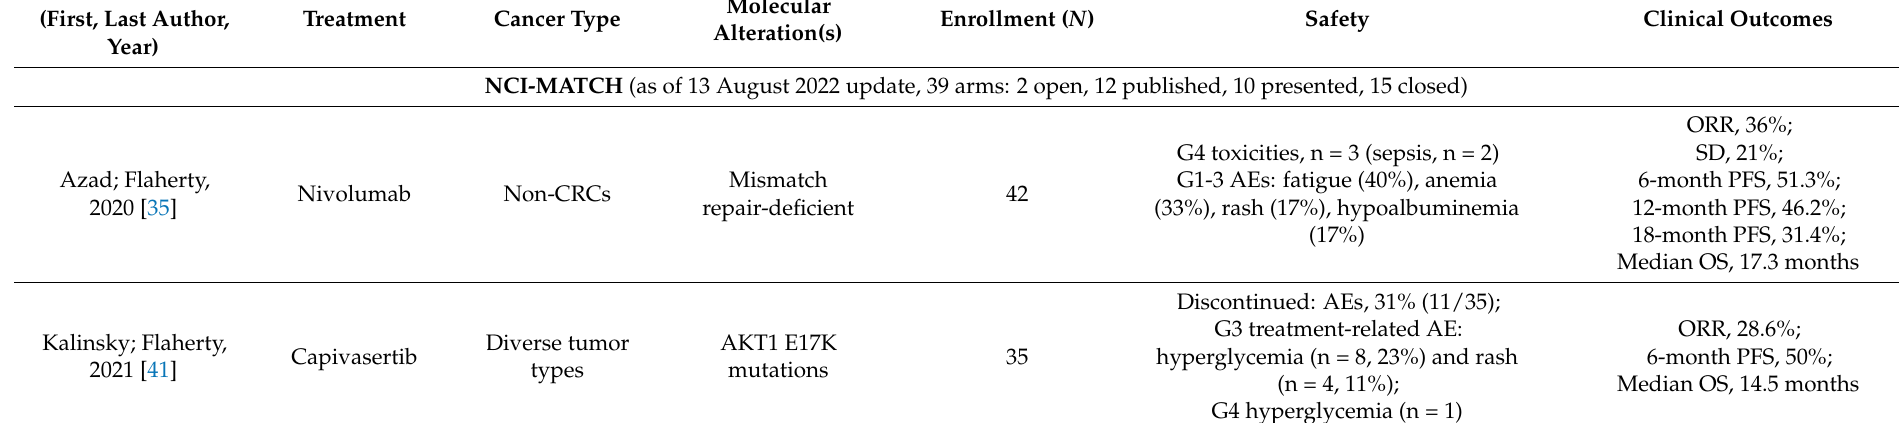
Table 2. Subprotocols of the non-randomized NCI-MATCH and TAPUR studies across tumor types with positive results. Published